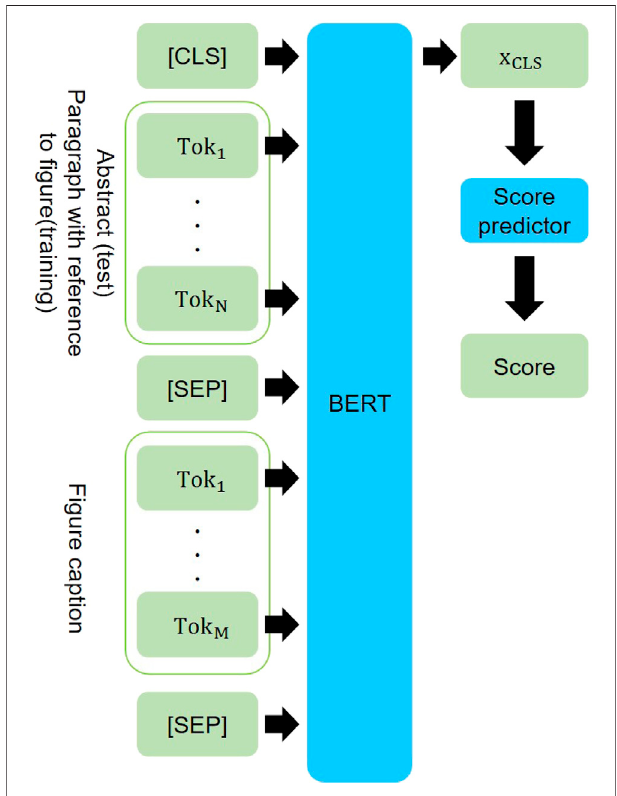
FIGURE 3 | Our model for abstract-caption pair scoring. Paragraphs explicitly mentioning fi gures are paired with the fi gure captions during training.